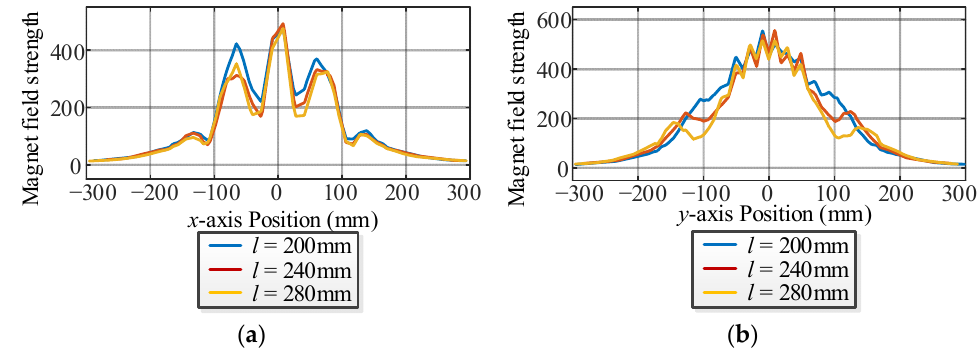
Figure 8. Magnet field strength waveforms with different lengths. ( a ) x ‐ axis. ( b ) y ‐ axis.